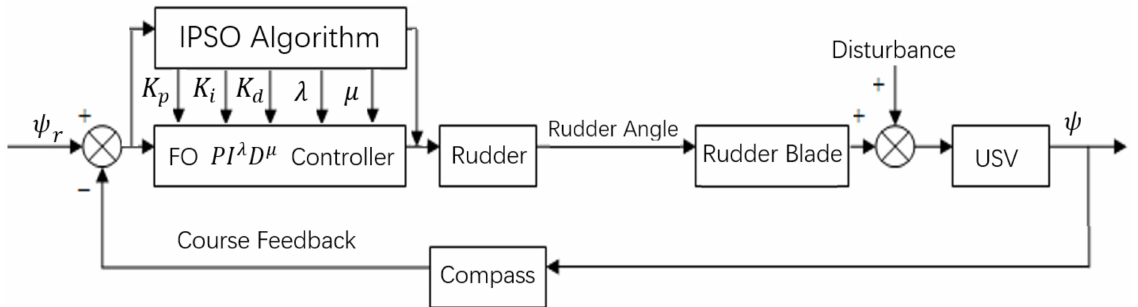
Figure 7. FO PI λ D µ control system of ship’s course based on IPSO.